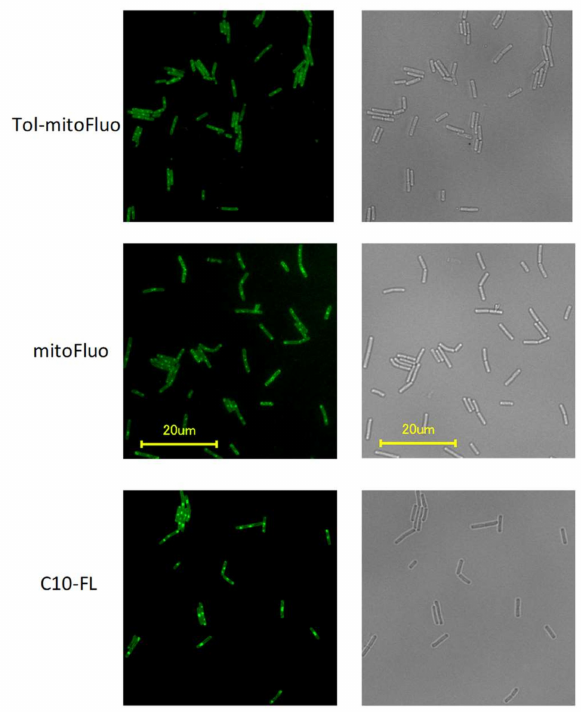
Figure 6. Fluorescence from B. subtilis cells stained with tol-mitoFluo (top row), mitoFluo (middle row), and C10-FL (bottom row), and the corresponding transmission light images. The cells were incubated with 5 µ M of the dyes for 5 min, washed with LB and